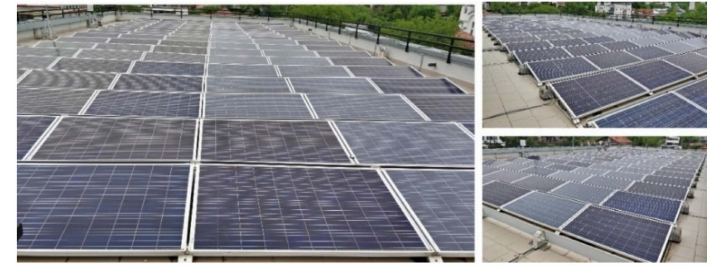
Figure 3. PV panels installed at the CETATEA building. Main characteristics of the PV panels are presented in Table 1. Table 1. PV panels’ main